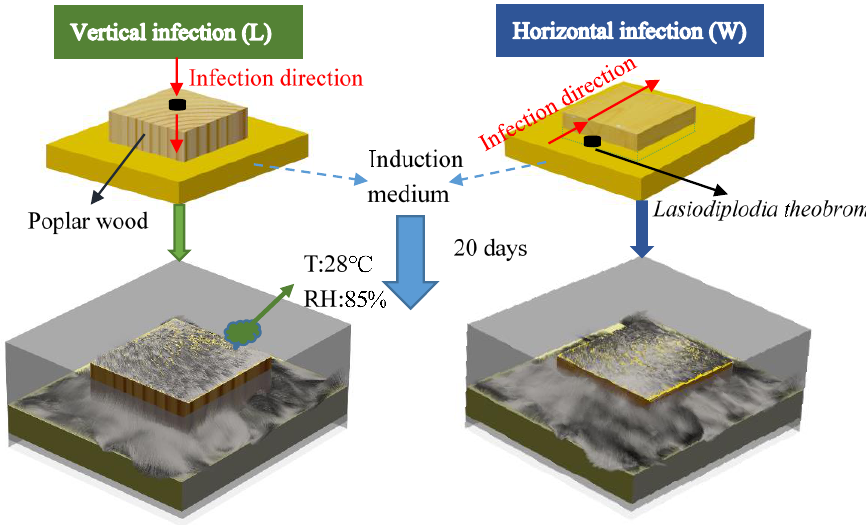
Figure 1. Biological dyeing process of vertical and horizontal infection of poplar wood by Lasiodiplodia theobromae .